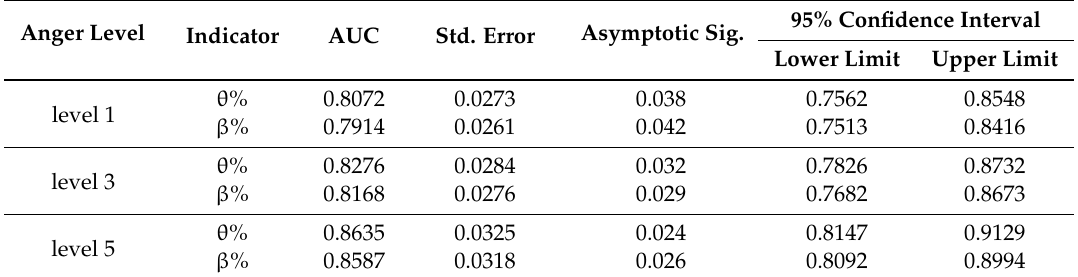
Table 2. Statistical analysis of AUC for indicator β % and θ % at different anger level.